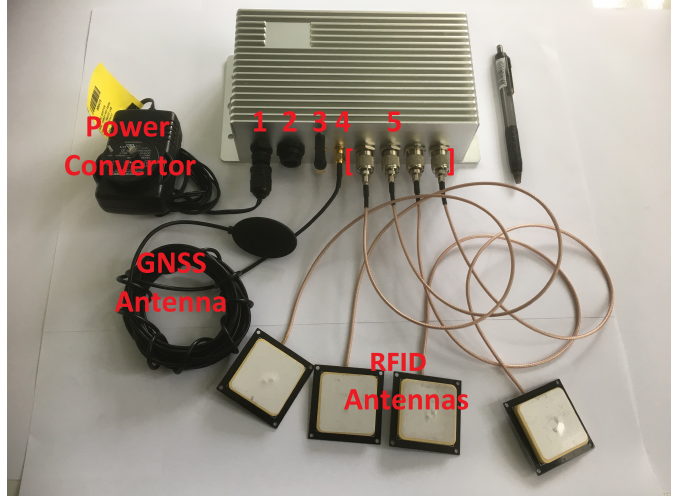
Figure 2. Aluminum housing (18.5cm × 10.5cm × 5.5cm) and peripherals. (1) 4-pin power inlet; (2) micro-USB port; (3) Wi-Fi antenna; (4) GNSS antenna, and (5) RFID antennas and